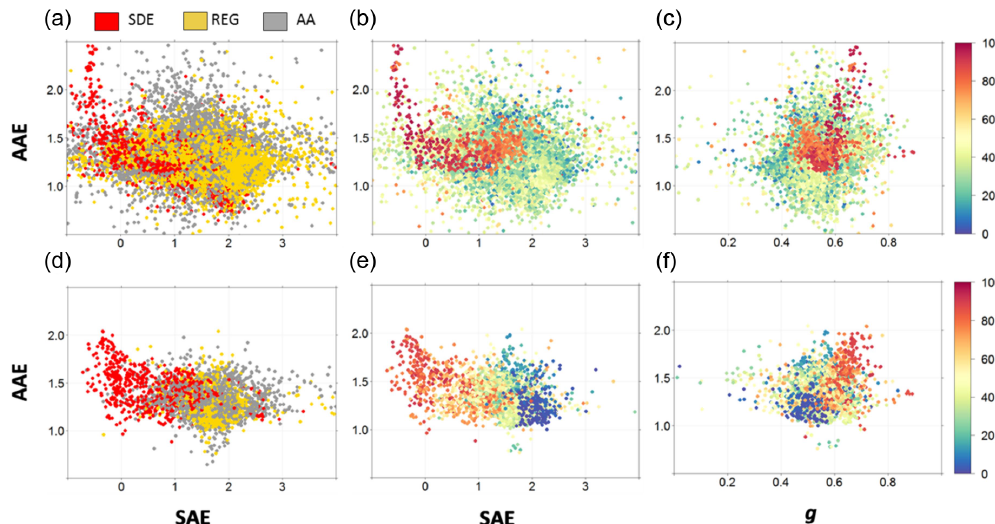
Figure 2. Ångström matrix (scatter plot of AAE vs. SAE weighted by air mass origin) at (a) MSY and (d) MSA. Ångström matrix (scatter plot of AAE vs. SAE weighted by levels of %PM 1 − 10 in PM 10 ) at (b) MSY and (e) MSA. Ångström-asymmetry parameter matrix (scatter plot of AAE vs. g weighted by levels of %PM 1 − 10 in PM 10 ) at (c) MSY and (f) MSA (on an hourly